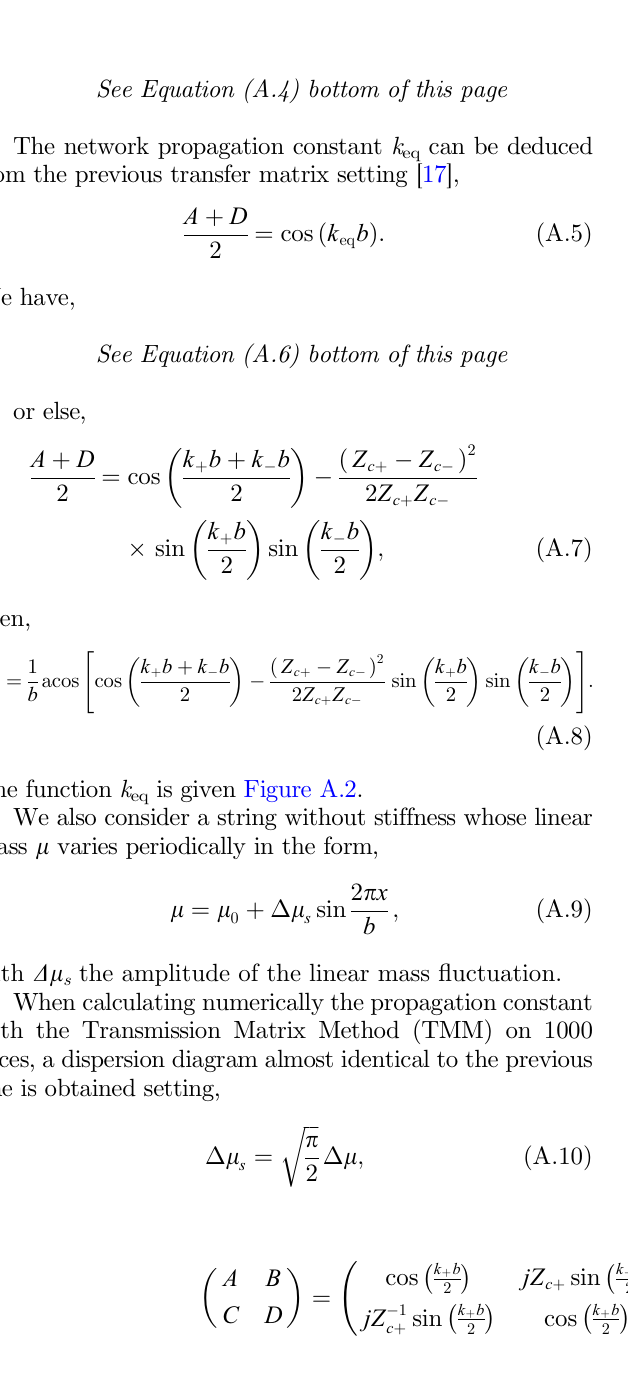
Figure A.1. Schematic view of a string with a square variation of the linear density and of a string with a sinusoidal variation of